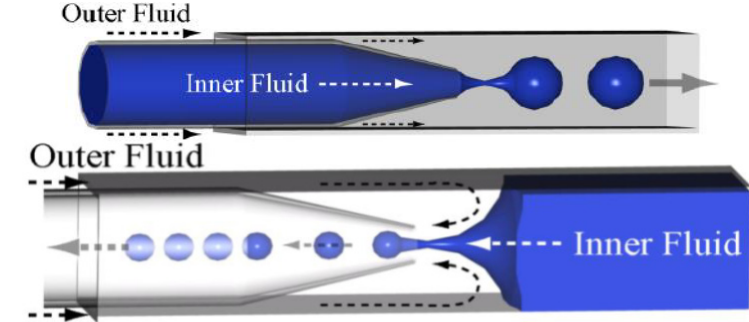
Figure 4. Formation of droplets ( a ) co-flow geometry and ( b ) Flow-focusing microcapillary device for making droplets [17].